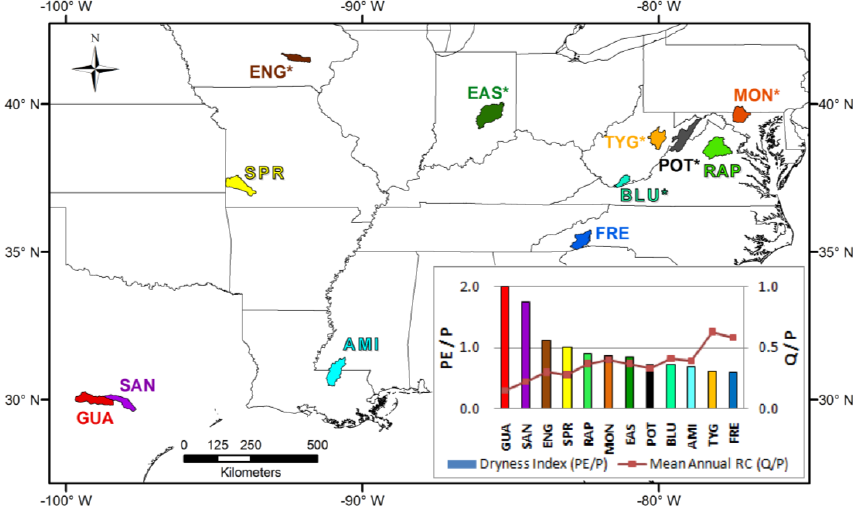
Fig. 3. Location of study sites and their aridity index and runoff coefficient for the period 1990–1999. Snow catchments are indicated with an *.